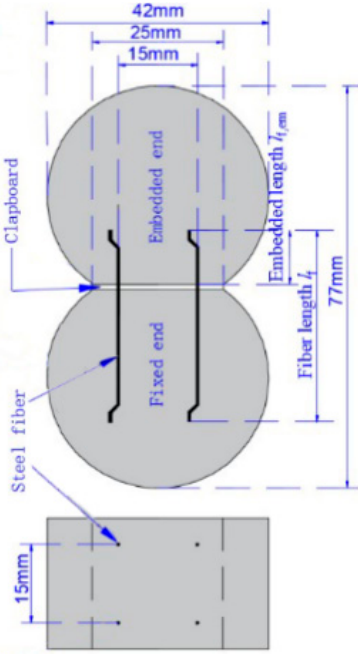
Figure 4. Detailed specimen design.